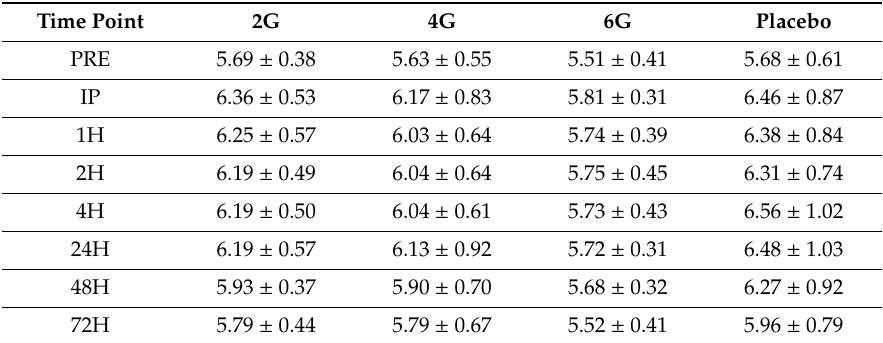
Table 4. Sprint (40-yd) time (s) for each group at all time-points. All values are seconds. n = 8 / group; 4 males and 4 females per